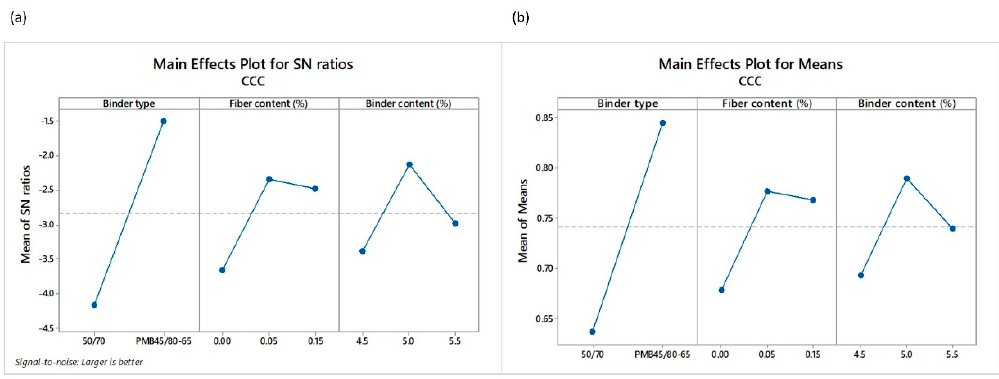
Figure 11. Main effects plots of ( a ) SNR and ( b ) means of the CCC